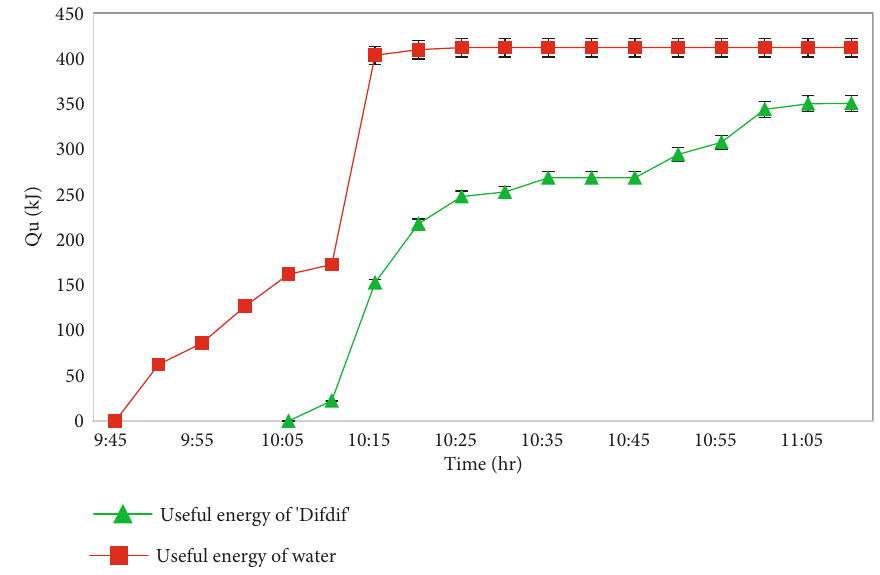
Figure 9: Useful energy gain by water in the receiver and “ Difdif ” in distillation